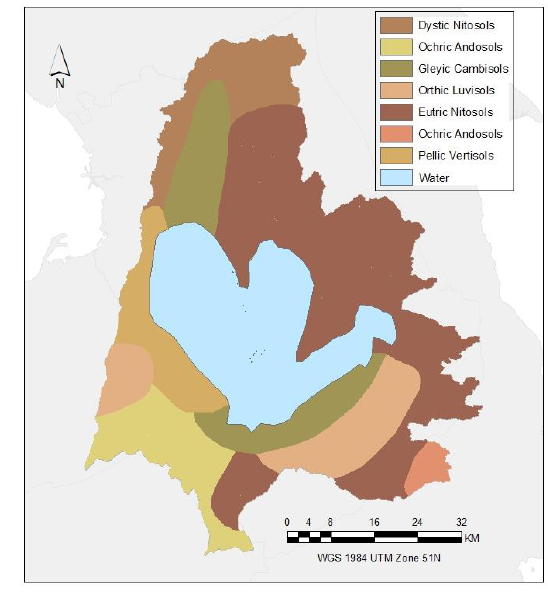
Figure 3 . Soil map of the study area.